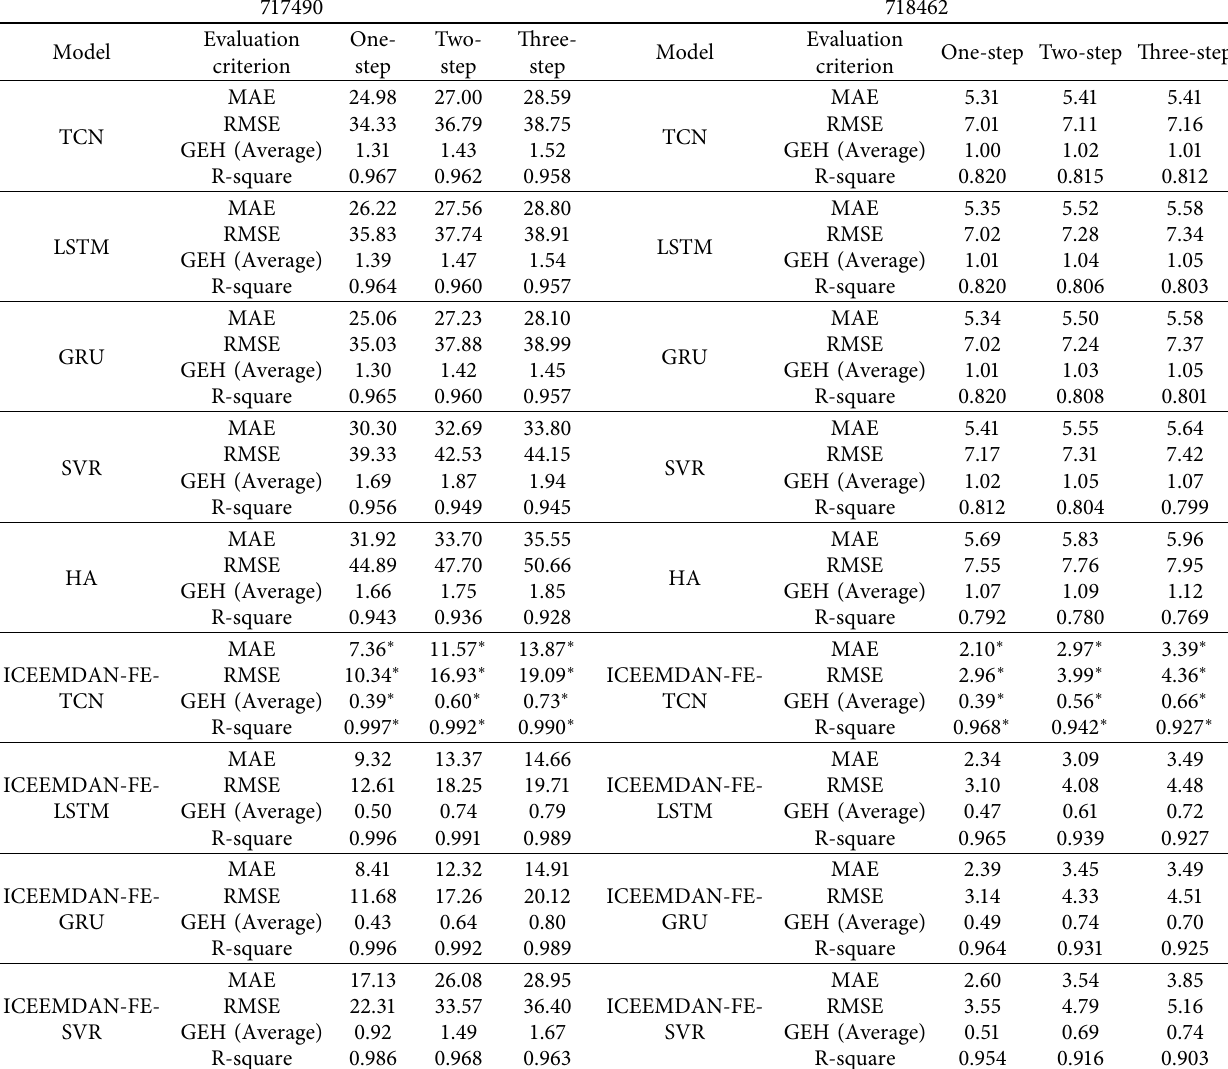
Table 7: Prediction error of different algorithms of 717490 and 718462. 717490